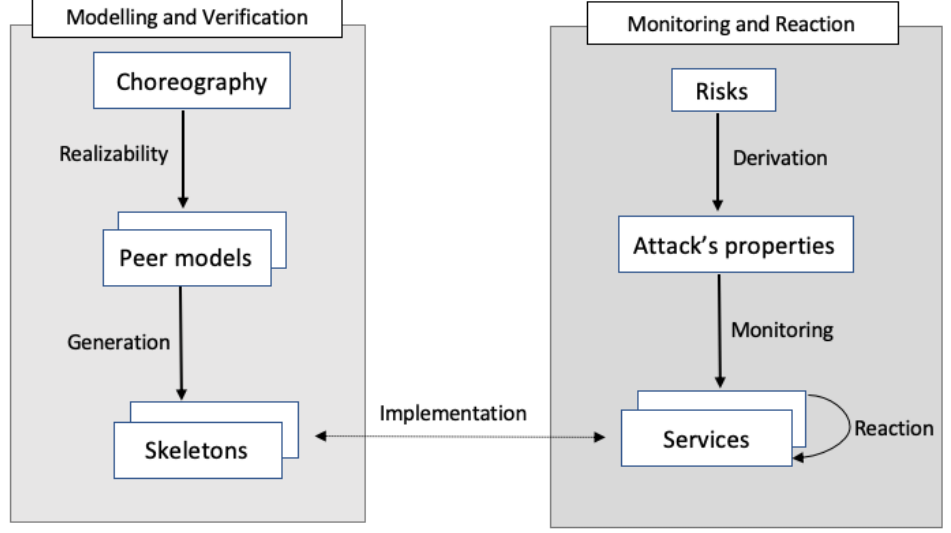
Figure 5. Architecture and components of the